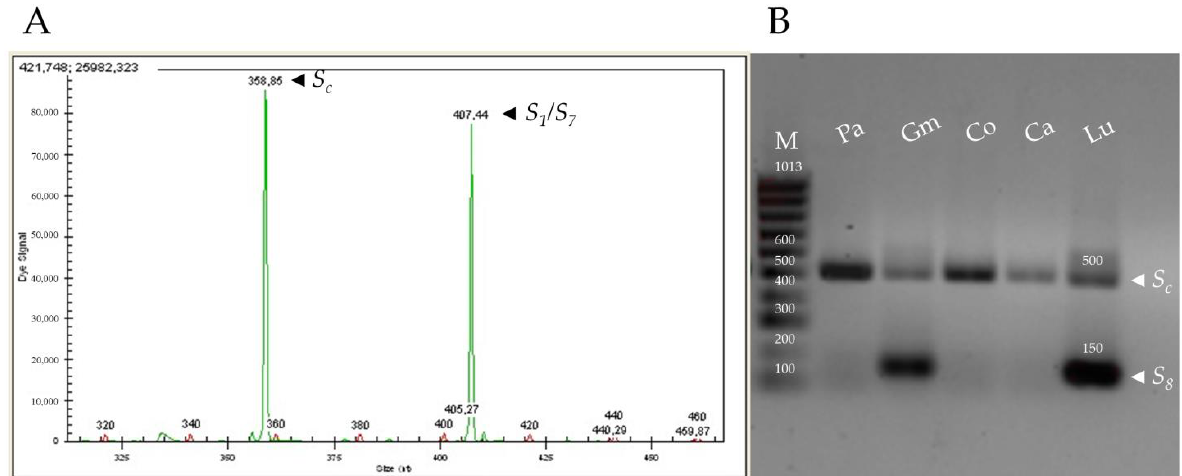
Figure 1. Size of the PCR amplification fragments using different primer pair combinations for the identification of S -alleles. ( A ) Gene analyzer output for the SRc-(F/R) primers showing the size of the two amplified fragments of the RNase first intron region corresponding to the S -alleles S c (358 bp, left) and S 1 / S 7 (408 bp, right) in apricot cv. ‘Rojo Pasión’. ( B ) PCR amplification with the AprFBC8-(F/R) primers for identifying S c - and S 8 -alleles in five apricot cultivars (Pa: ‘ Paviot ’ , Gm: ‘ Gönci Magyarkajszi ’ , Co: ‘ Corbato ’ , Ca: ‘ Canino ’ , and Lu: ‘ Luizet ’ ). M: 100 bp DNA Ladder.